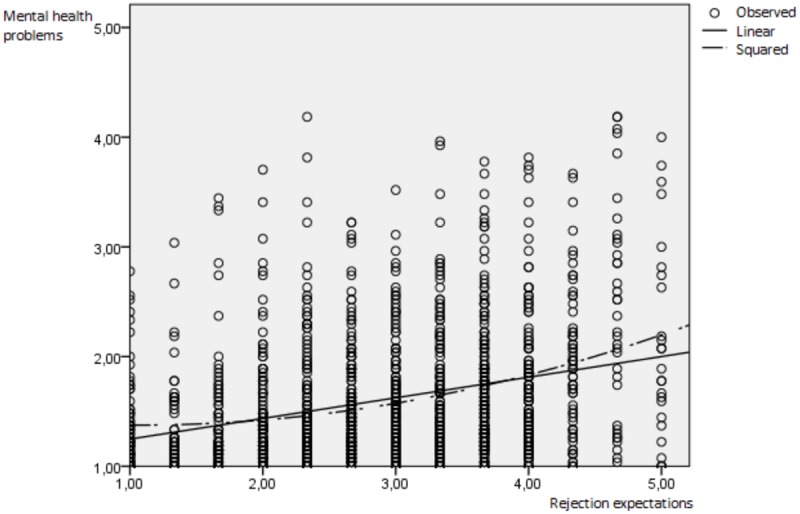
Linear and convex prediction of mental health problems by rejection expectations. Observed = observed value, linear = linear line of parameter estimation, squared = squared (convex) line of parameter estimation.